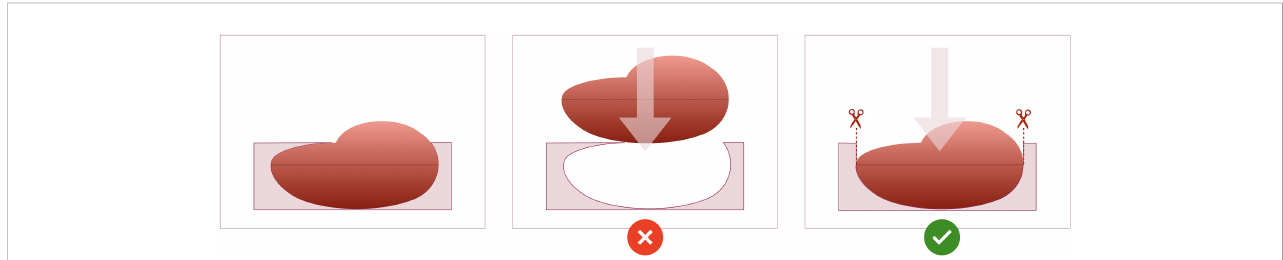
FIGURE 7 Schematic of the design of the mould cavity for cases in which the height of the cavity is greater than the height where the widest surface of the tumour